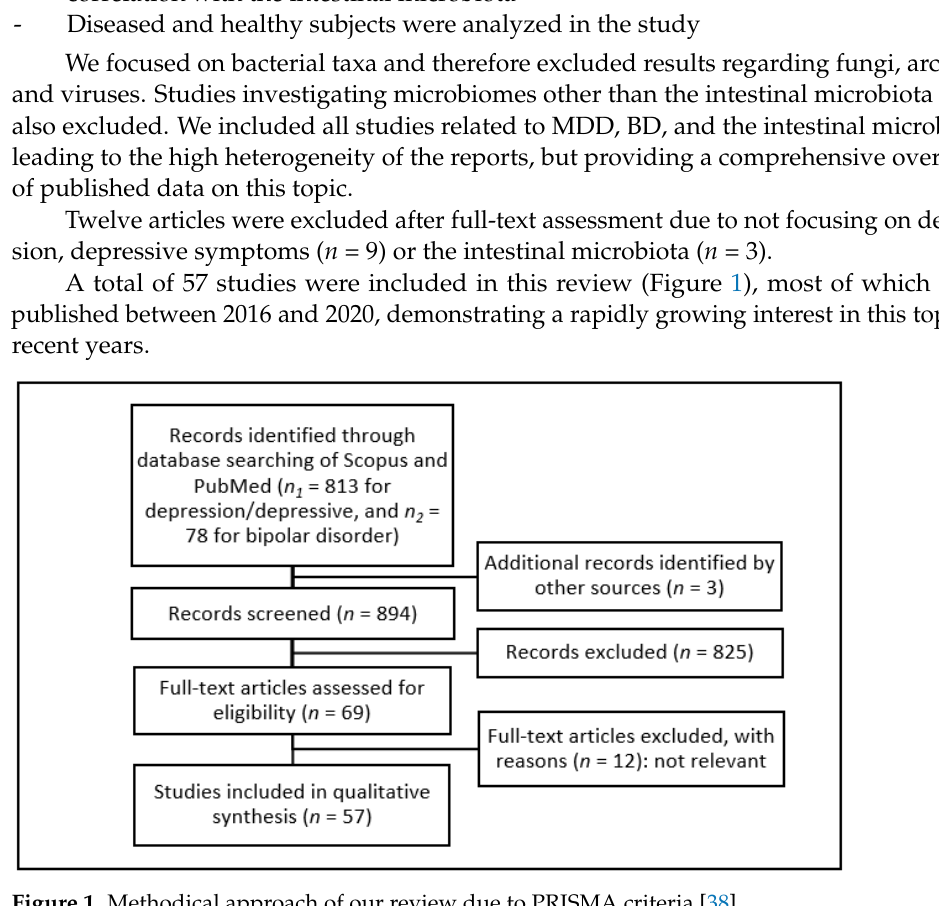
Figure 1. Methodical approach of our review due to PRISMA criteria